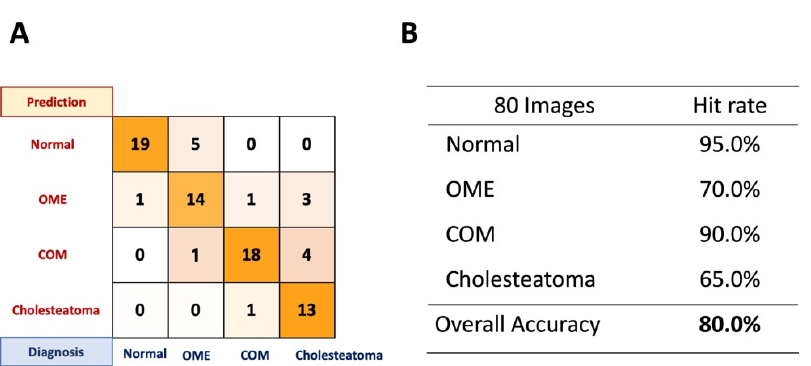
Figure 8. Performance of the machine learning network with 80 representative images. ( A ) Confusion matrix for representative images. ( B ) Overall accuracy of the machine learning network devised with Teachable Machine and hit rates for each classification.